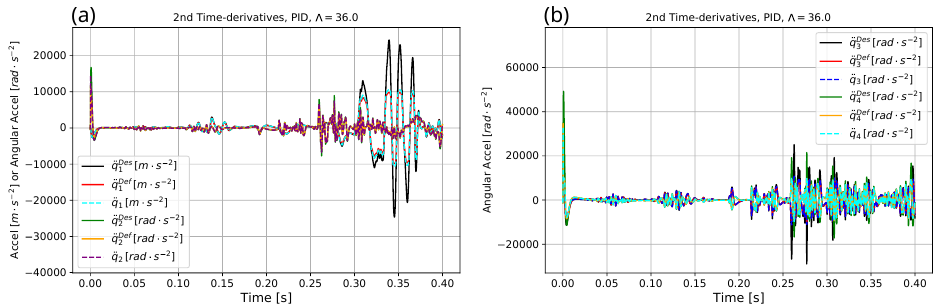
Figure 24. Trajectory tracking errors with force limitation ∆ u = 495.0 N or N · m for the increased α min = 0.1: ( a ) For nominal-optimized: q N − q O . ( b ) For optimized-realized: q O − q .